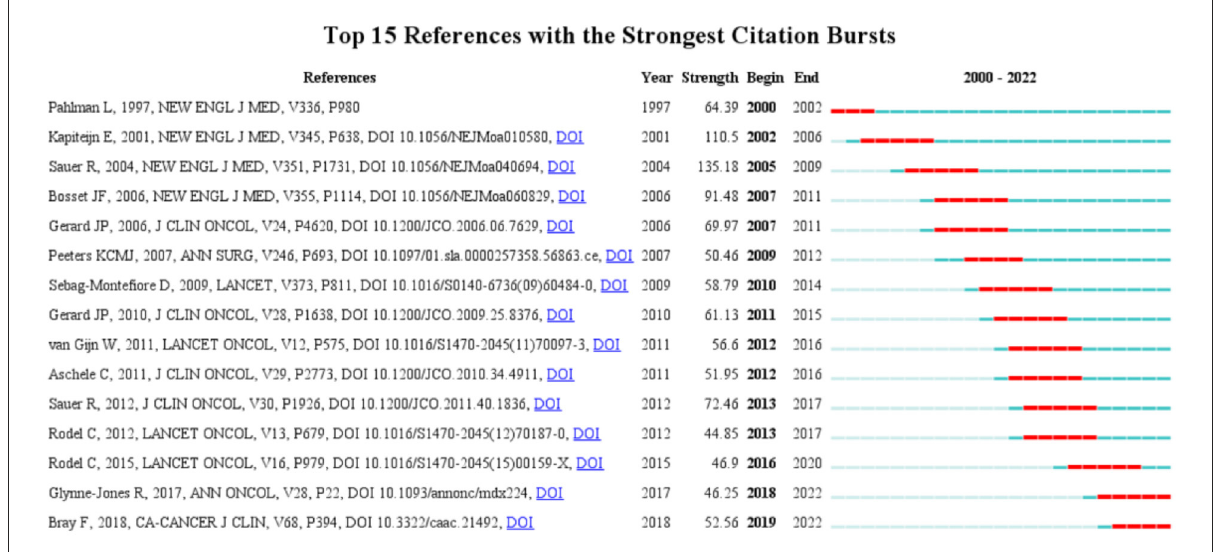
FIGURE5 Top 15 articles related to radiation therapy for rectal cancer with burst period after